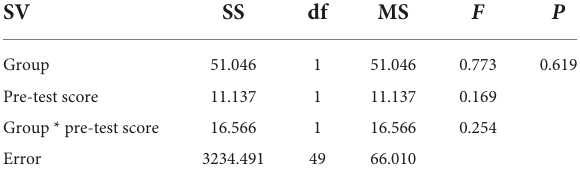
TABLE 2 The statistical analysis of pre-test results of learning